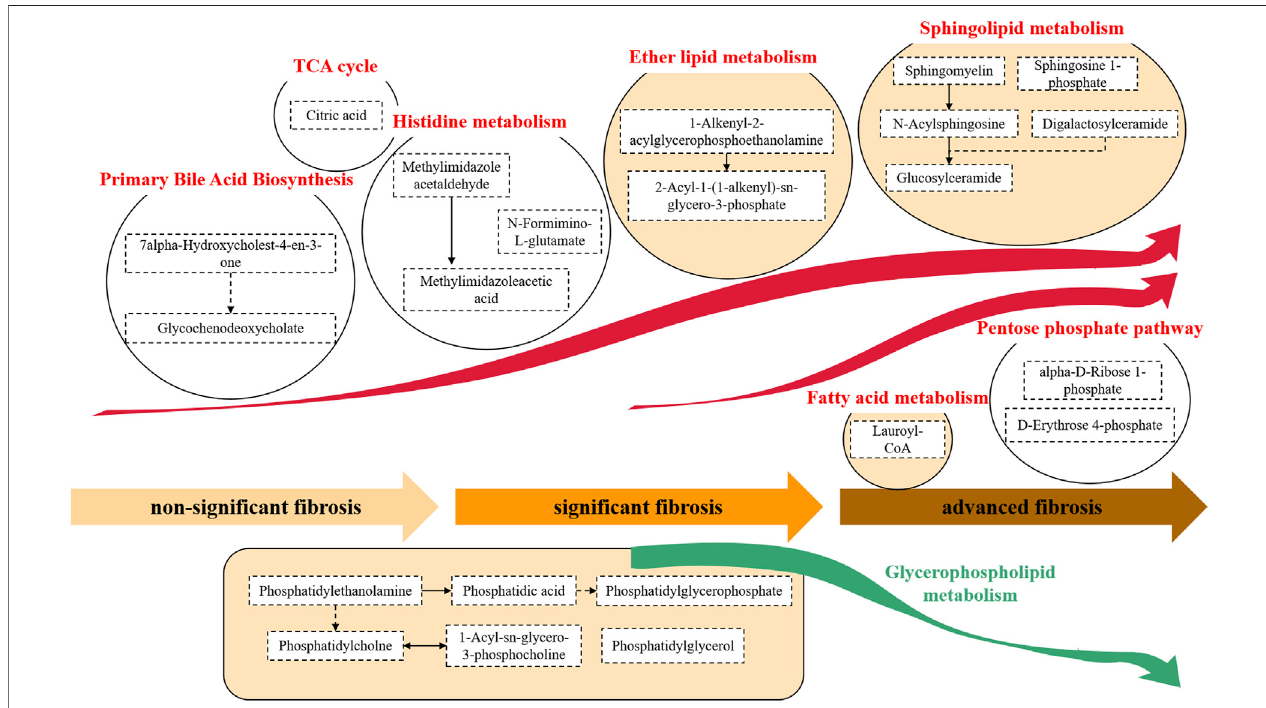
FIGURE 4 | Metabolite pathway alterations involved in chronic DILI with fi brosis. A typical feature was that the synthesis of primary bile acids and histidine metabolites, and a series of metabolites related to lipids (e.g., ether lipid and sphingolipid) were signi fi cantly increased. This accumulation of lipid metabolisms persisted from the development of nonsigni fi cant fi brosis to signi fi cant fi brosis to advanced fi brosis. In advanced fi brosis, metabolites of the fatty acid and pentose phosphate pathways were accumulated while the glycerophospholipid metabolites were found to decrease.